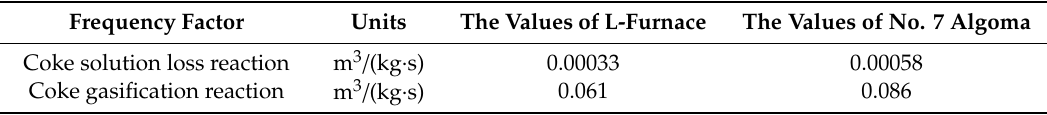
Table 2. Values of frequency factor in the simulation. Frequency Factor Units The Values of